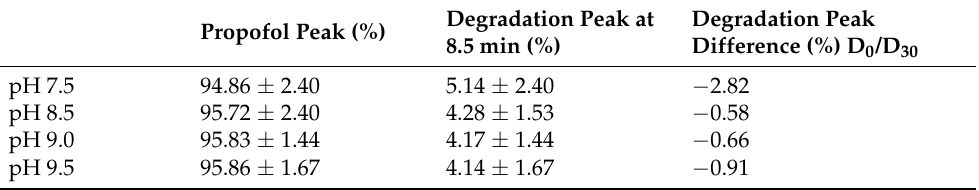
Table 10. Chemical stability of propofol heat-sterilized after 30 days of storage at room temperature. Propofol Peak (%)